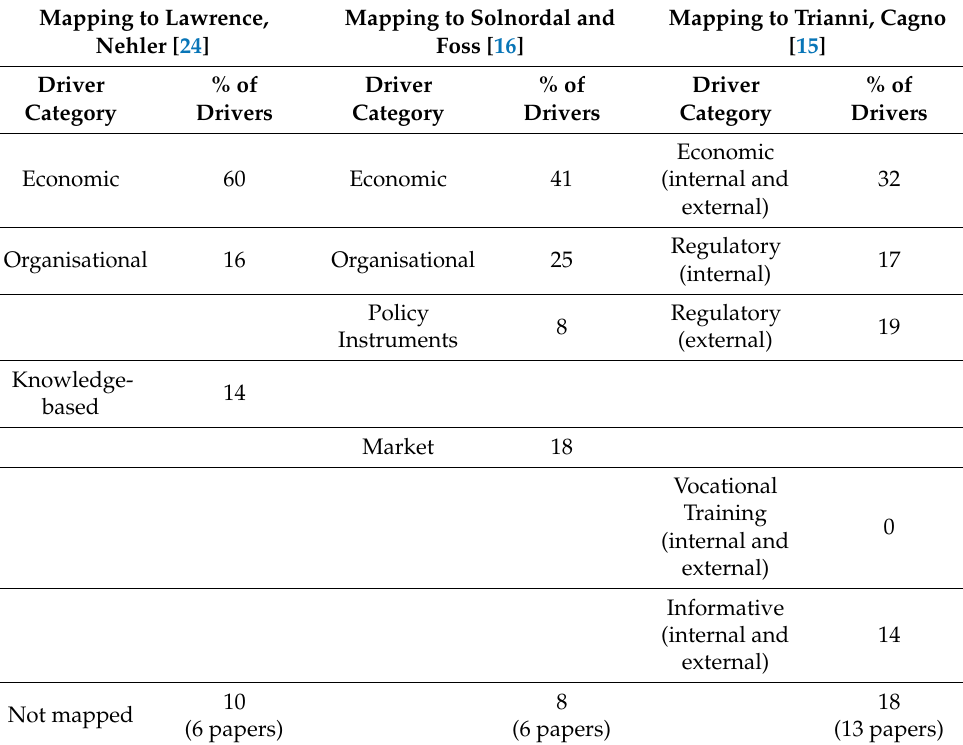
Table 4. Mapping of drivers from papers using survey and/or interview to contemporary literature